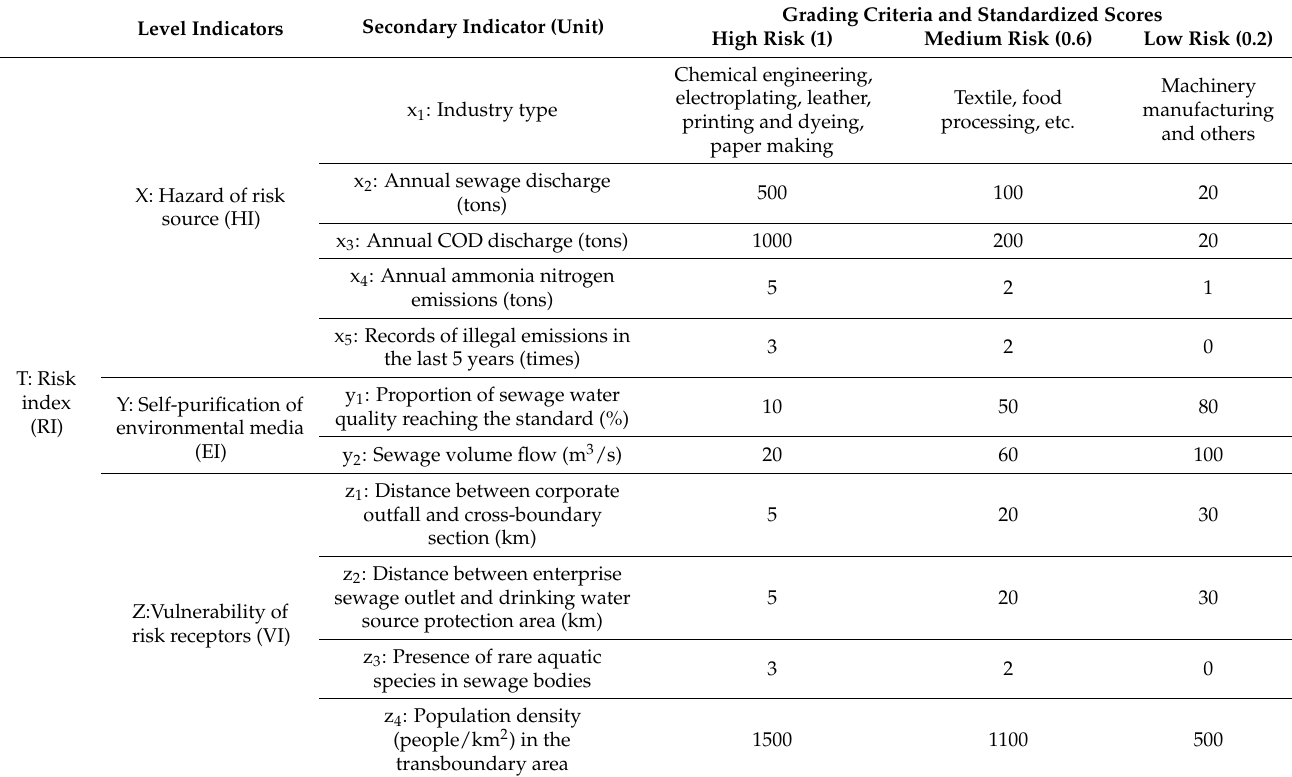
Table 1. Risk assessment index system for production enterprises in the transboundary zone.